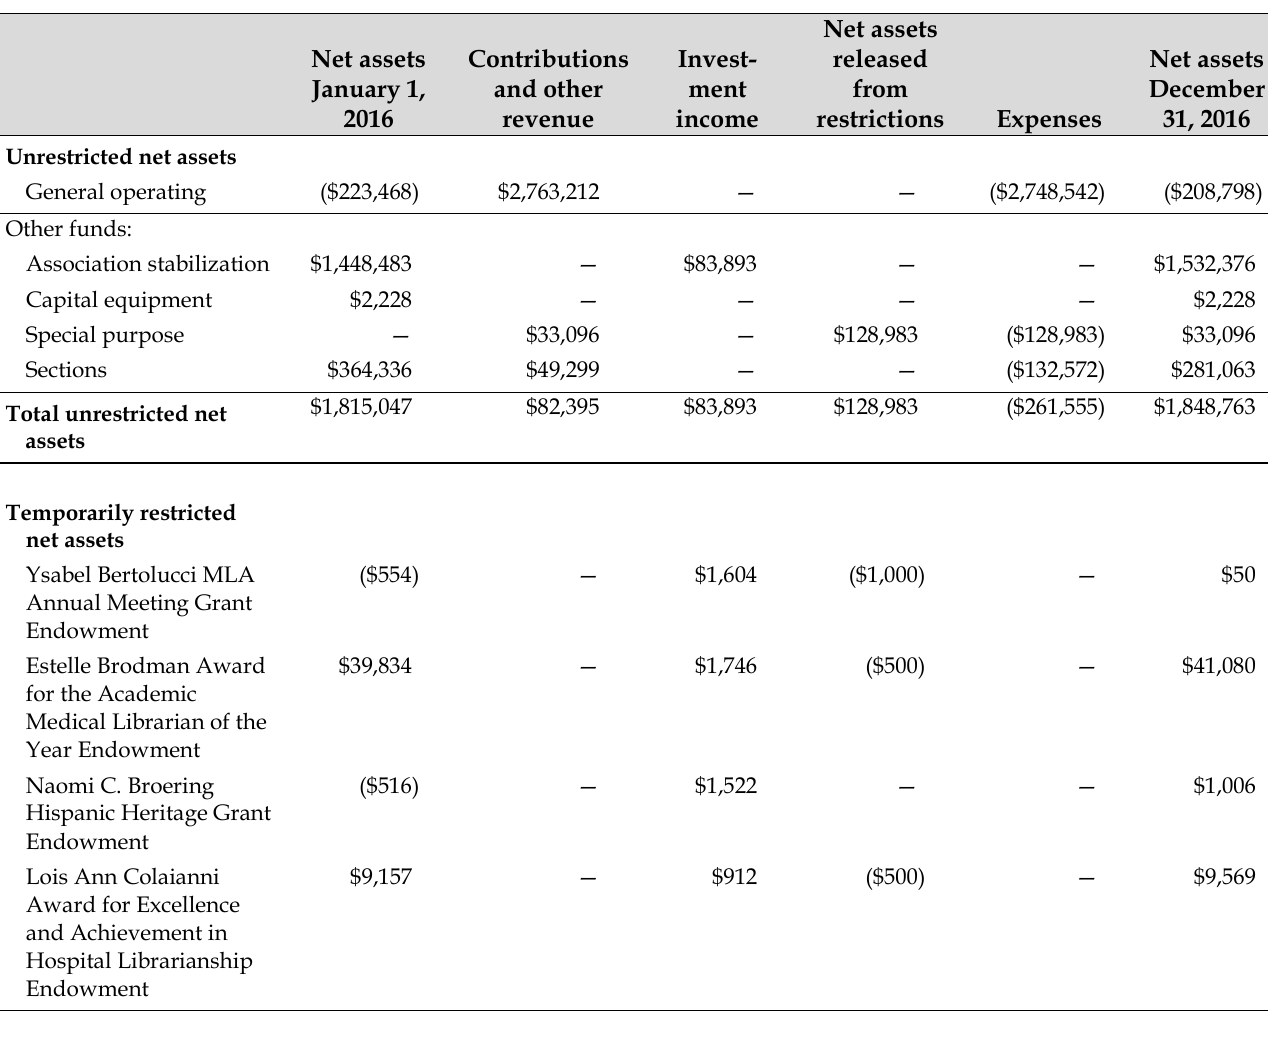
Table 1 Medical Library Association schedule of changes in net assets by fund year ended December 31,